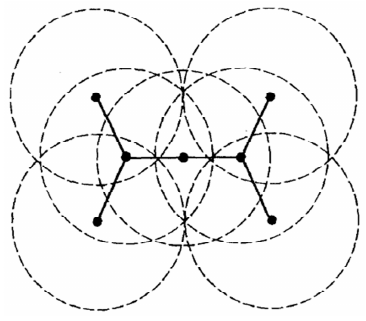
Figure 1. Unit-disk graph.